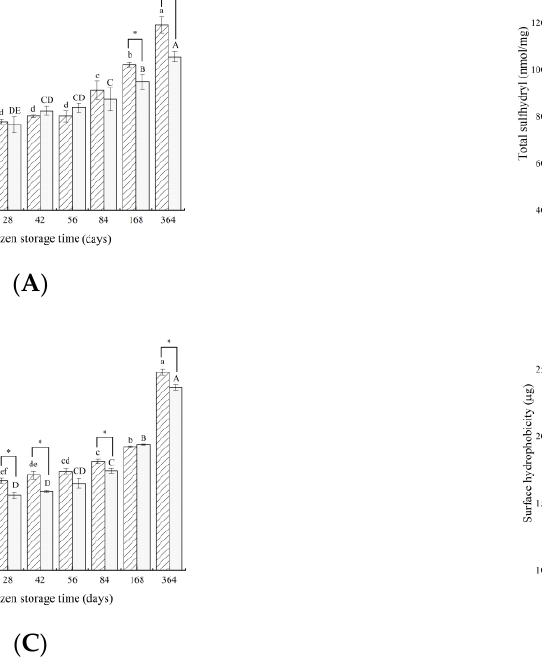
Figure 1. Changes in carbonyl ( A ), total sulfhydryl ( B ), disulfide bond content ( C ) and surface hydrophobicity ( D ) of yak rumen SMP during frozen storage. Different superscript letters in the figure indicate significant difference in storage time ( p < 0.05); lowercase letters are used for OWP and uppercase letters for VP. “*” indicates that the different packaging is significant ( p < 0.05), and “**” indicates that the differen t packaging is extremely significant ( p < 0.01).